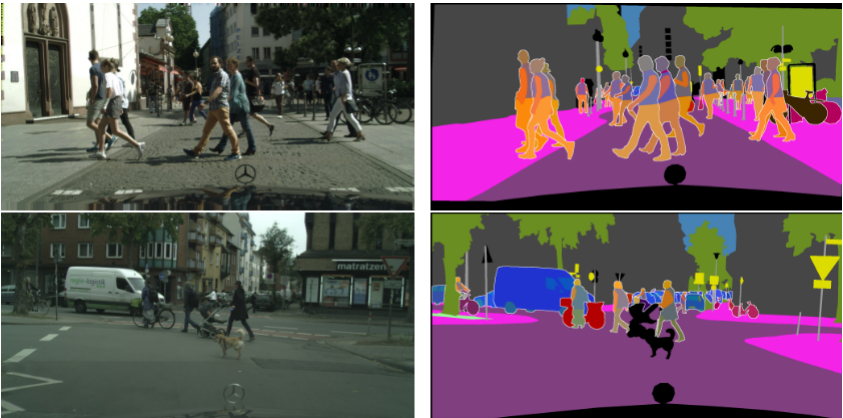
Figure 2. Examples of fine-grained segmentation. This picture comes from Cityscapes Panoptic Parts